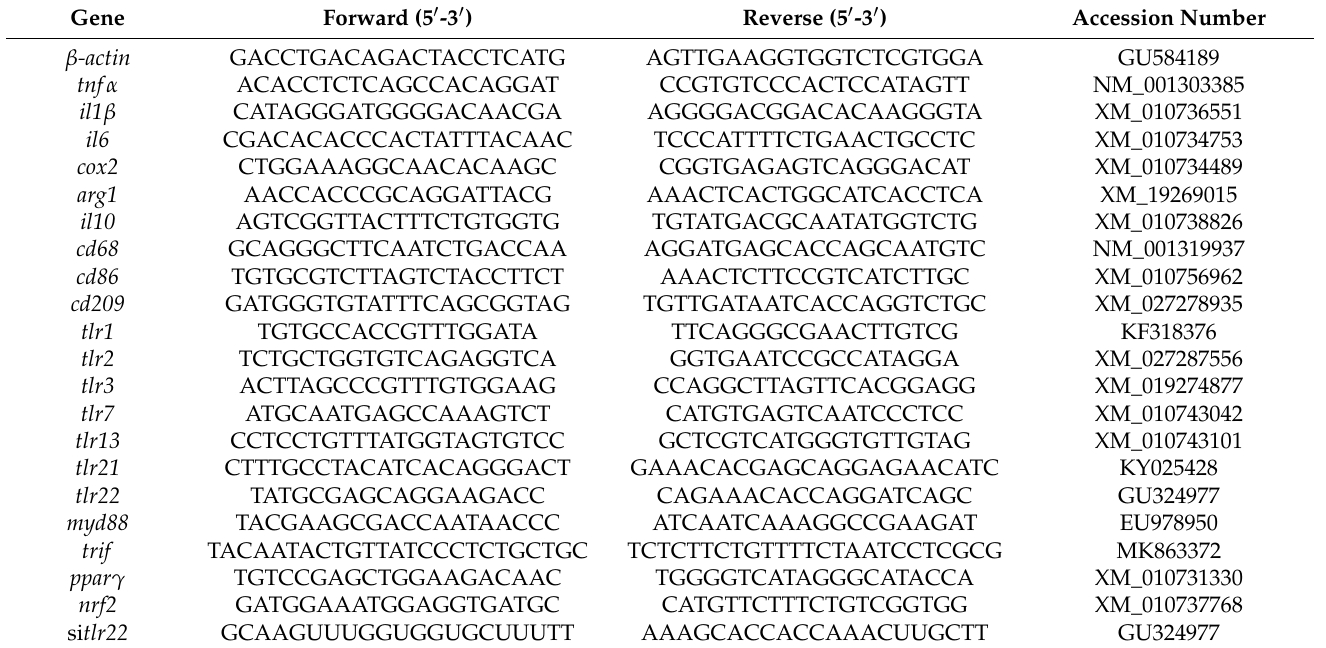
Table 1. Primers used for RT-qPCR and the gene accession